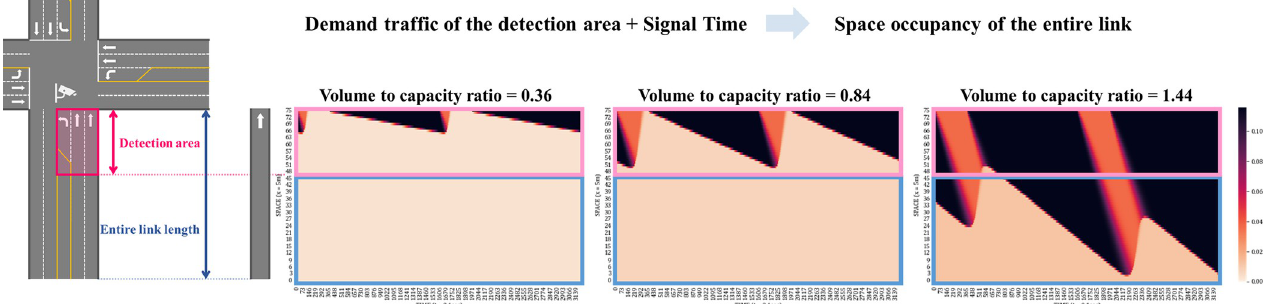
Fig 2. Calculation of the space occupancy based on the collected traffic and signal